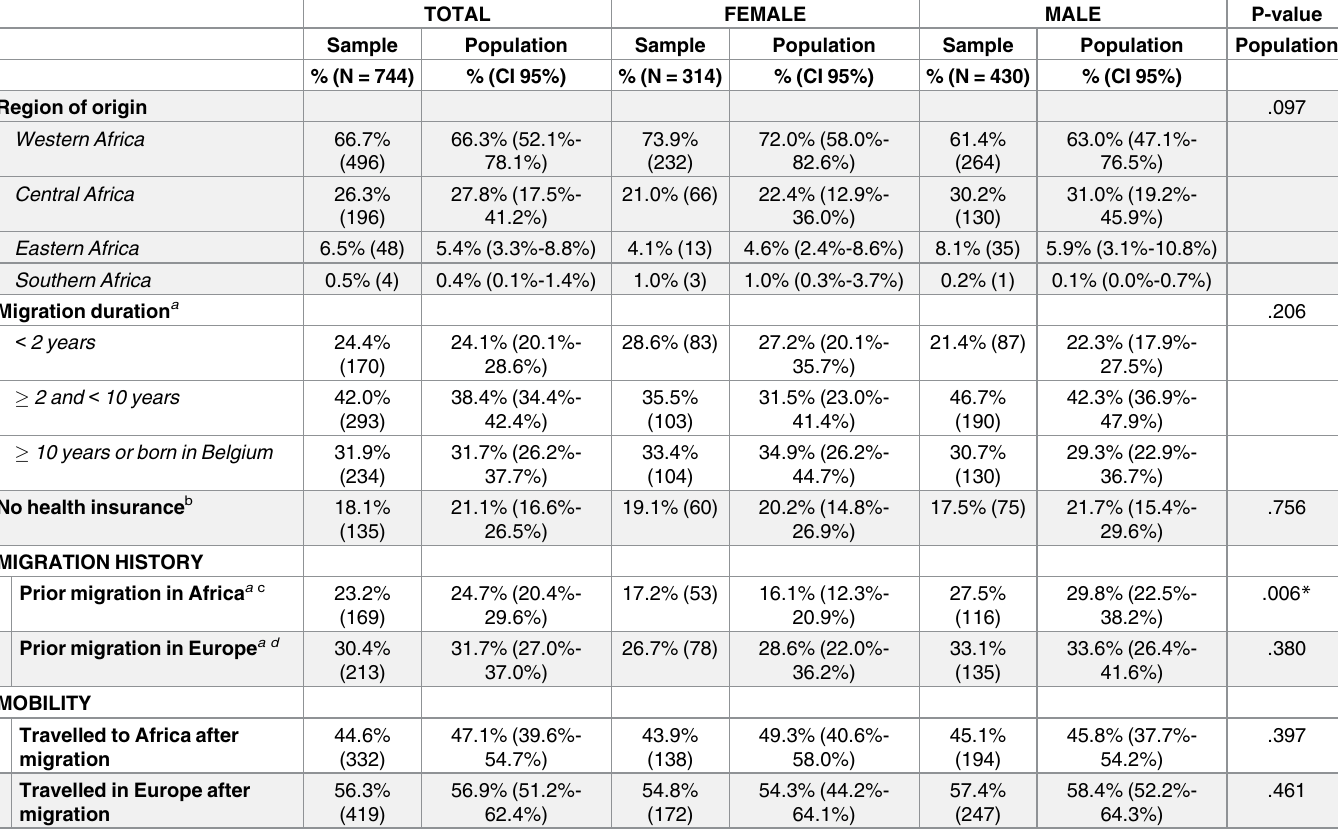
Table 2. Migration related characteristics of the sample (unweighted) and population estimatesof sub-Saharan African migrants socializing in Antwerp city (weighted), stratified by